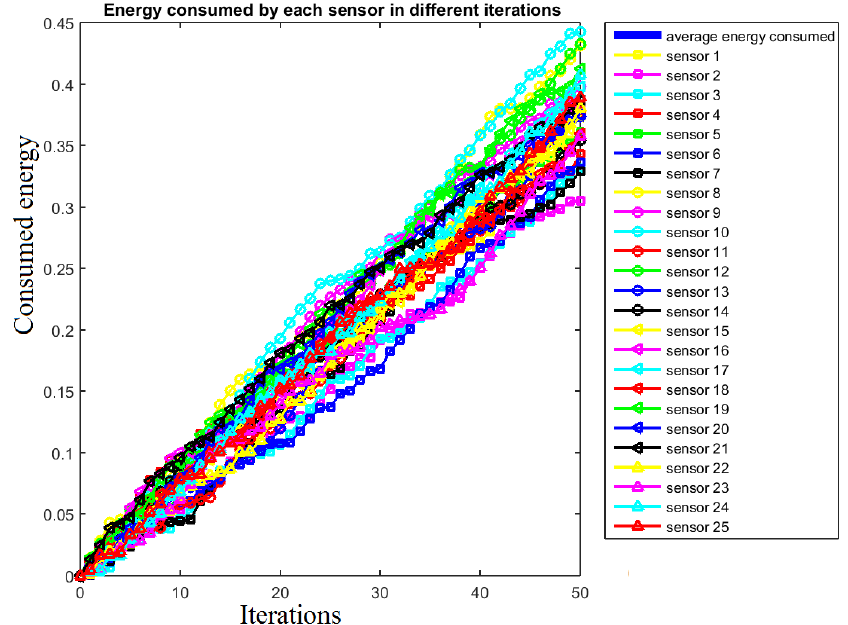
Figure 7. Energy consumption by each node in each